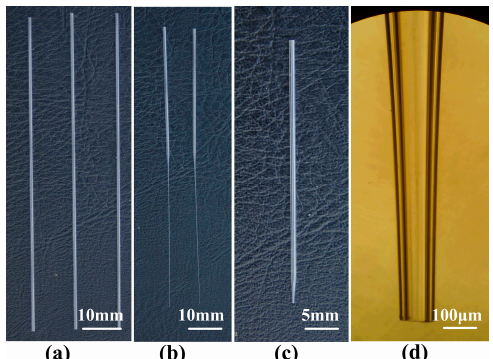
Figure 4. Fabrication of the borosilicate glass micro-nozzle: ( a ) borosilicate glass pipe; ( b ) micro-nozzle after being pulled; ( c ) micro-nozzle after being cut; ( d ) micrograph of micro-nozzle after being cut.